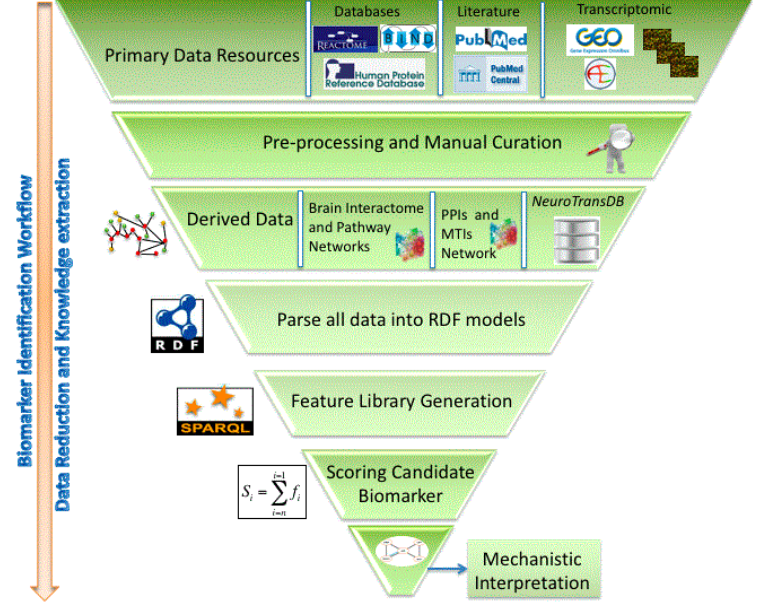
Figure 3. Workflow for Resource Description Framework (RDF)-mediated data and knowledge integration and the identification of “signals” in a network context. The workflow essentially identifies subgraphs in the feature network that are highly discriminating between healthy and diseased; the term “long list” describes a list of “interesting network features” that provide contextual, mechanistic insight that can be analyzed by experts in the field.